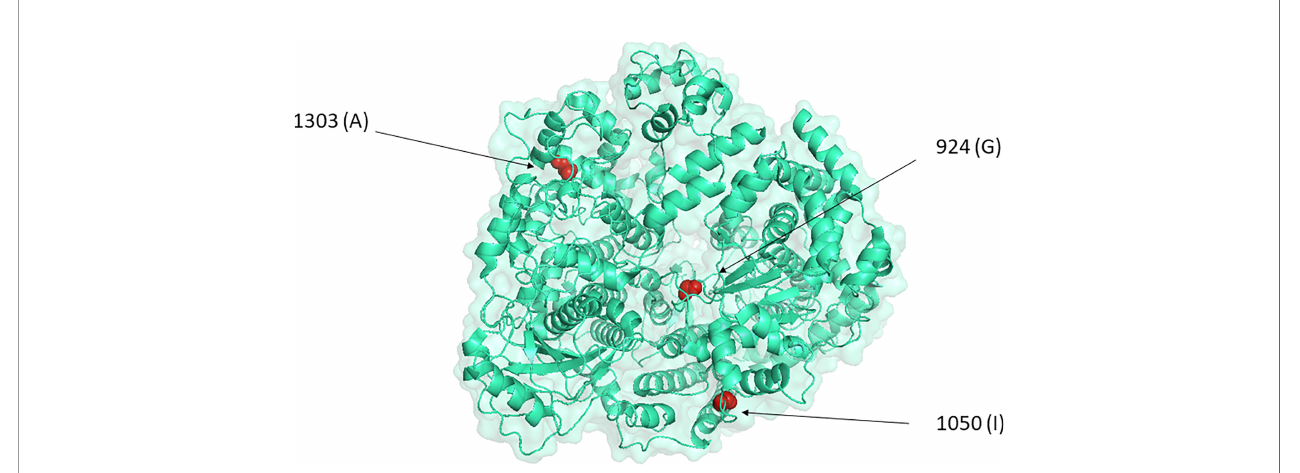
FIGURE 6 | Location of the three positions under study in the representation of RVFV L-protein by PyMOL, as de fi ned by the cryo-EM model (accession code 7EEI, (Wang et al.,